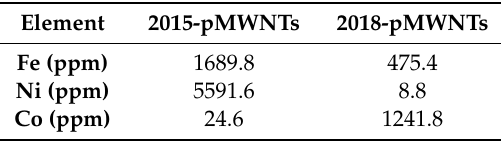
Table 3. ICP-MS analyses of pMWNT